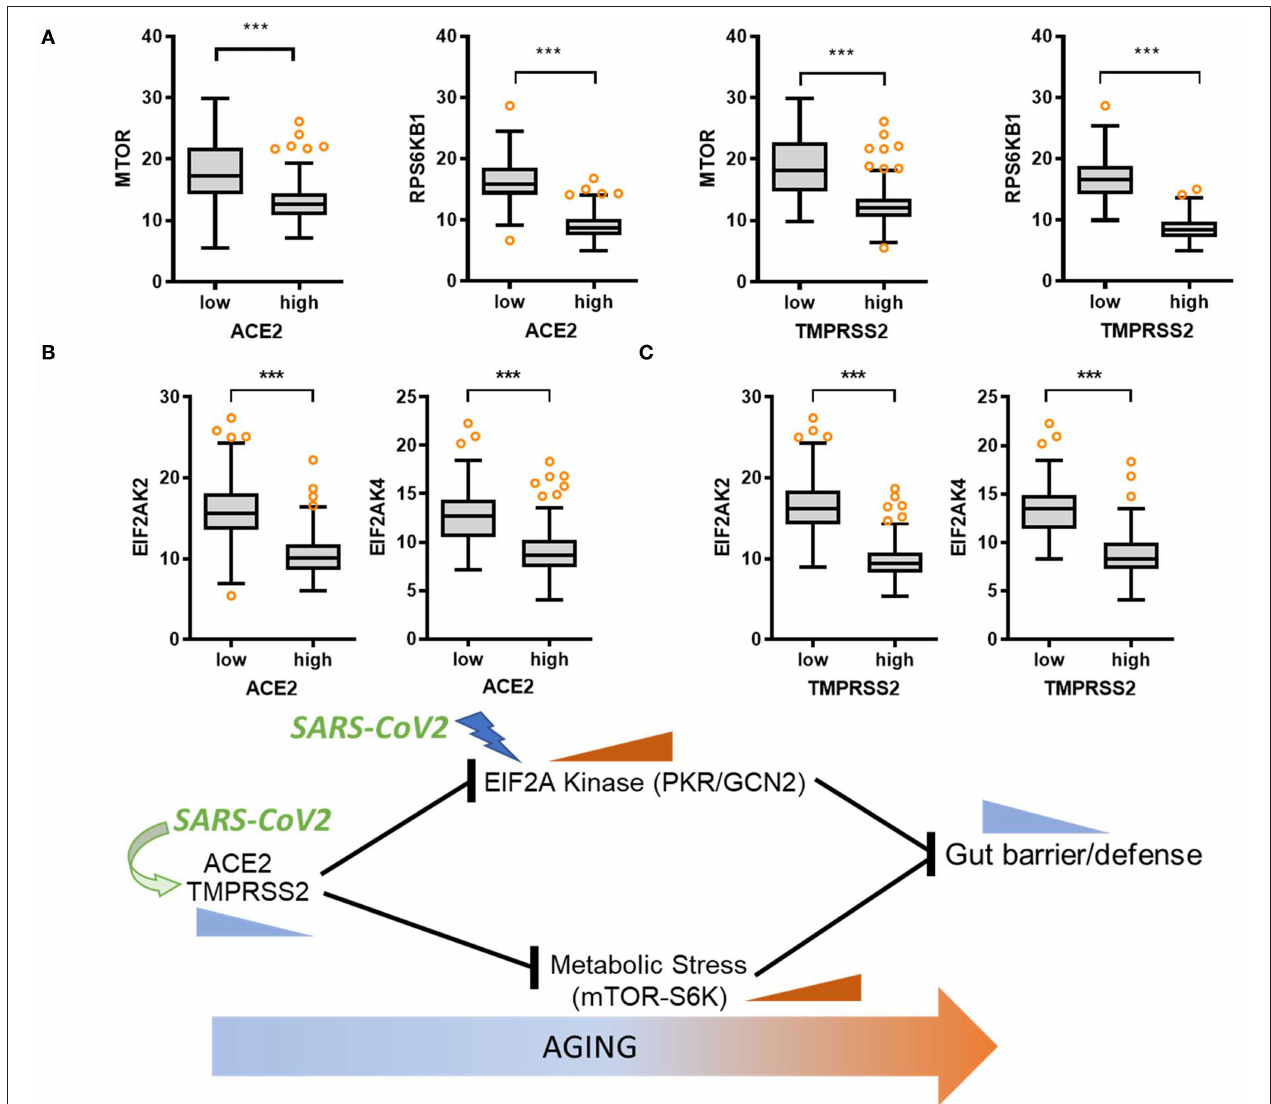
FIGURE 6 | Regulation of stress responsive biomarkers by SARS-CoV-2 receptor. Considering the ACE2 or TMPRSS2 levels in normal mucosal intestinal tissues (GTEx dataset v8), we selected the 150 highest and 150 lowest level samples, which were further evaluated based on the expression of cell metabolic stress markers ( A , mTOR or RPS6KB1 ) or eIF2 α kinases ( B , EIF2AK2 or EIF2AK4 ). Values are presented as transcripts per million (TPM). Asterisks (*) indicate significant differences from the low expression group (*** p < 0.001). (C) A putative scheme for SARS-CoV-2 receptor-mediated modulation of gut barrier defense with age. In response to SARS-CoV-2 infection, SARS-CoV-2-responsive receptors positively contribute to maintenance of gut barrier defense via suppressing two stress signaling pathways including eIF2 α kinase and mTOR-S6